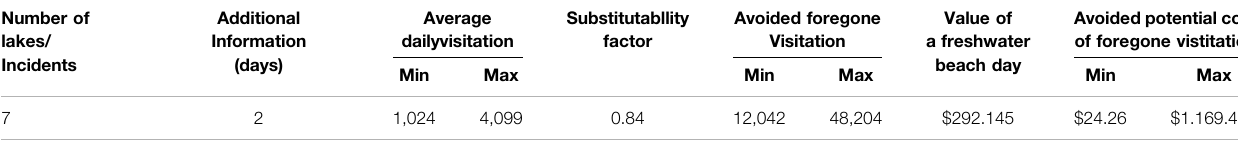
TABLE 1 | Avoided recreational losses from cyanobacteria harmful algal bloom information. Number of lakes/